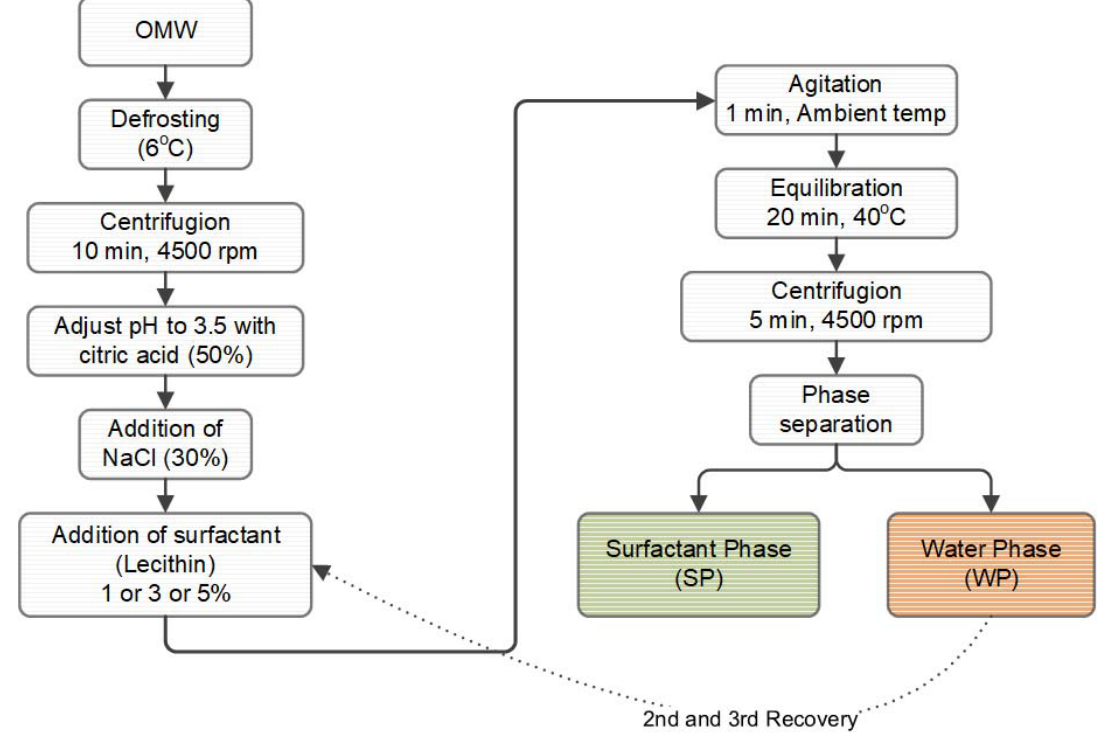
Figure 1. Experimental steps of the CPE method for the extraction of polyphenols from OMW.